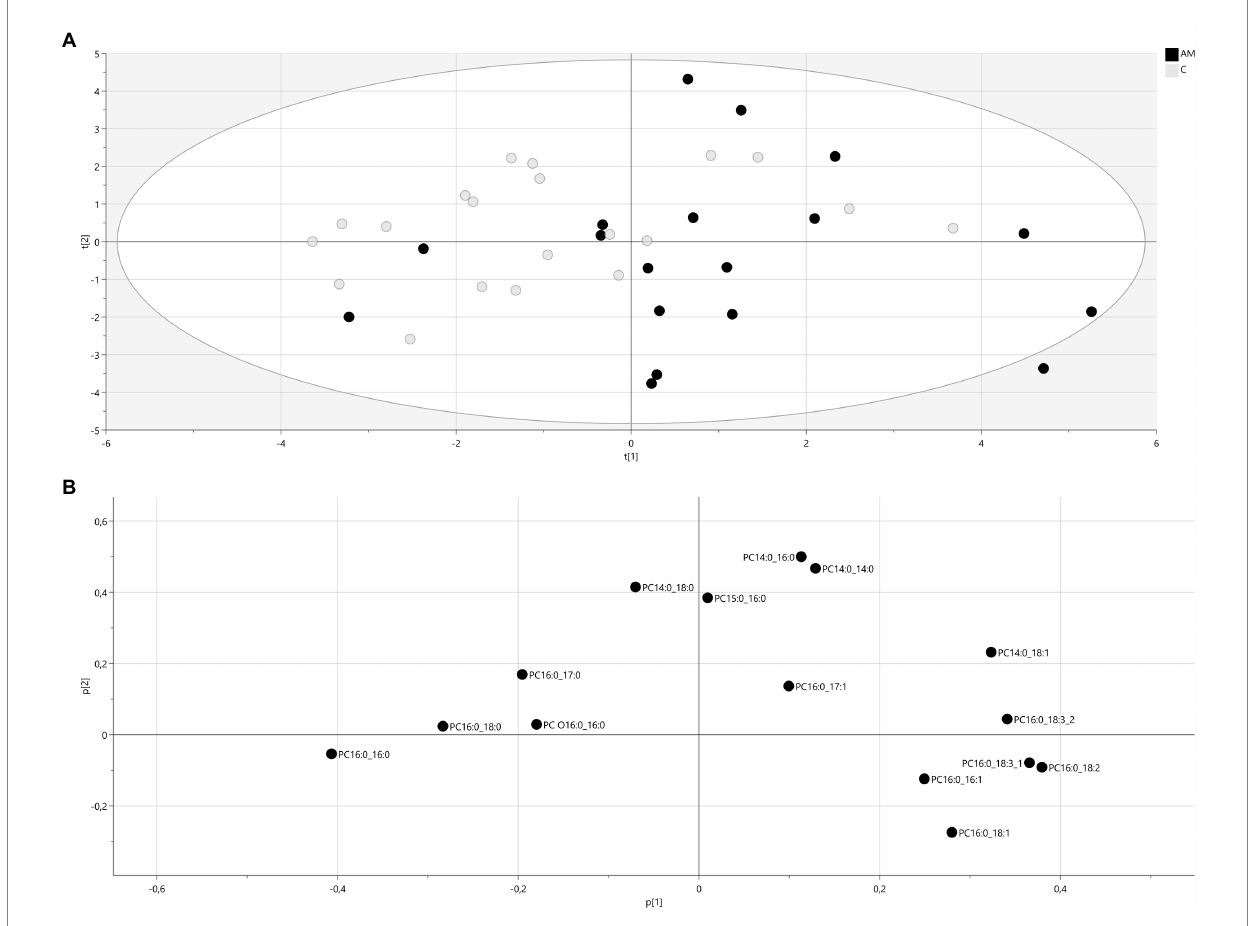
FIGURE 2 Principal component analysis (A) score plot of PC lipids (R2X( cum ) = 0.575, Q2 ( cum ) = 0.282), filled circles: AM operators, unfilled circles: controls. t(1): first principal component, t(2):second principal component and (B) corresponding loadings plot. A variable with a positive loading is positively correlated to the principal component, and negative loadings indicate a negative correlation. PC: phosphatidylcholine, number of carbons:number of double